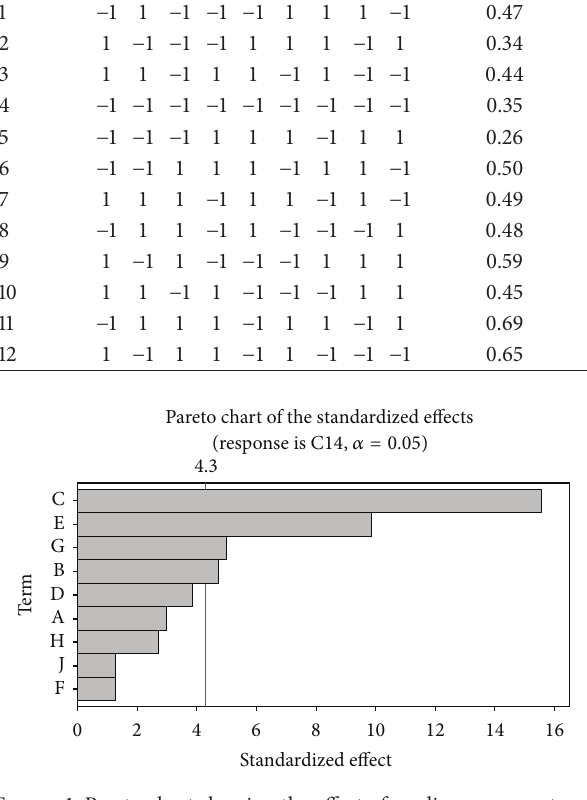
Figure 1: Pareto chart showing the effect of media components on xylitol